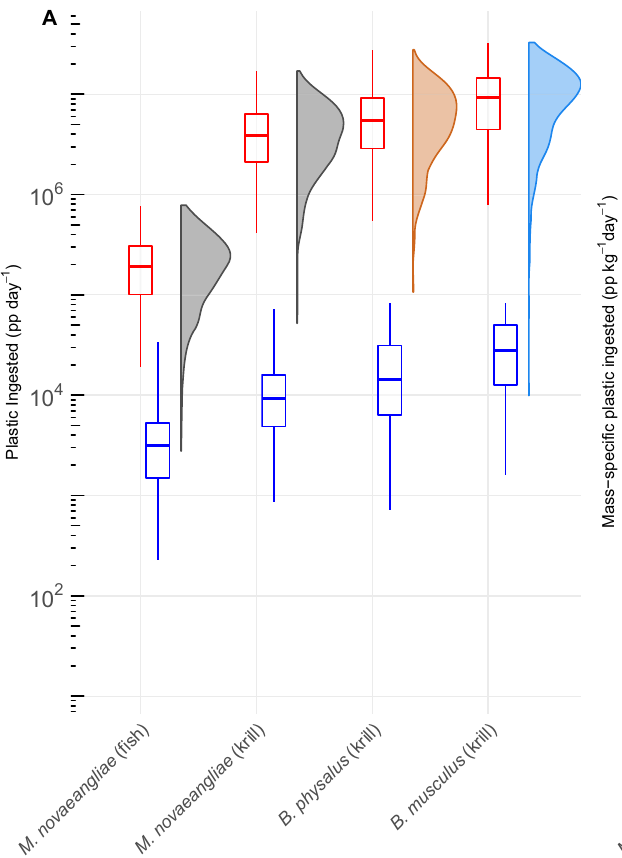
represent the total microplastic ingested per feeding day ( fi ltration+feeding). A Total number of plastic particles potentially ingested per day via fi ltration and preyconsumption; B Mass-speci fi c(whalemass,inkilograms)totalplasticparticles per day. Source data are provided as a Source Data fi